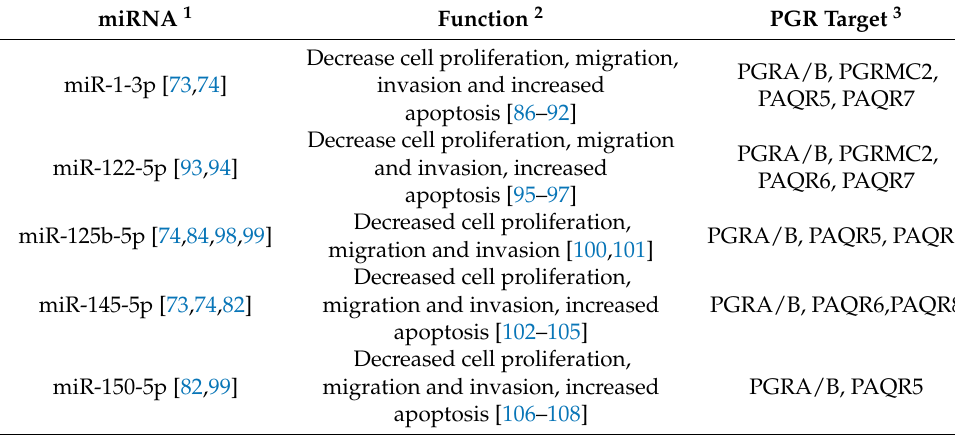
Table 1. miRNAs elevated in endometriosis which are predicted to target PGRs which suppress cellular events conducive to endometriosis progression and